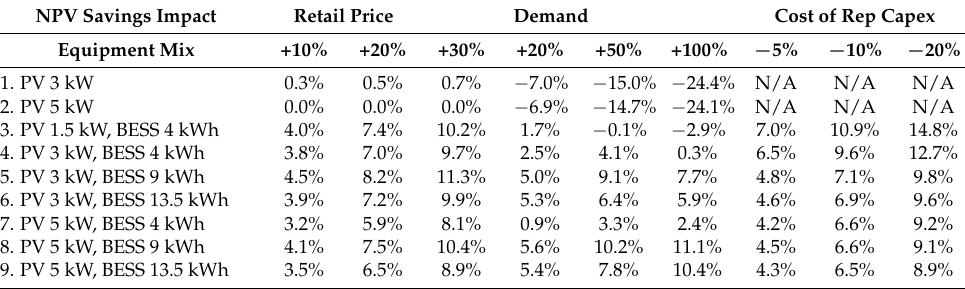
Table 11. Sensitivities to retail price, demand, and capex replacement, change in NPV savings %.